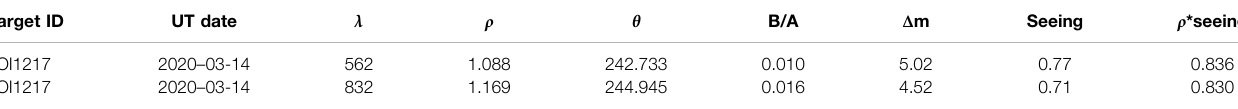
TABLE 2 | Binary fi t results for TOI